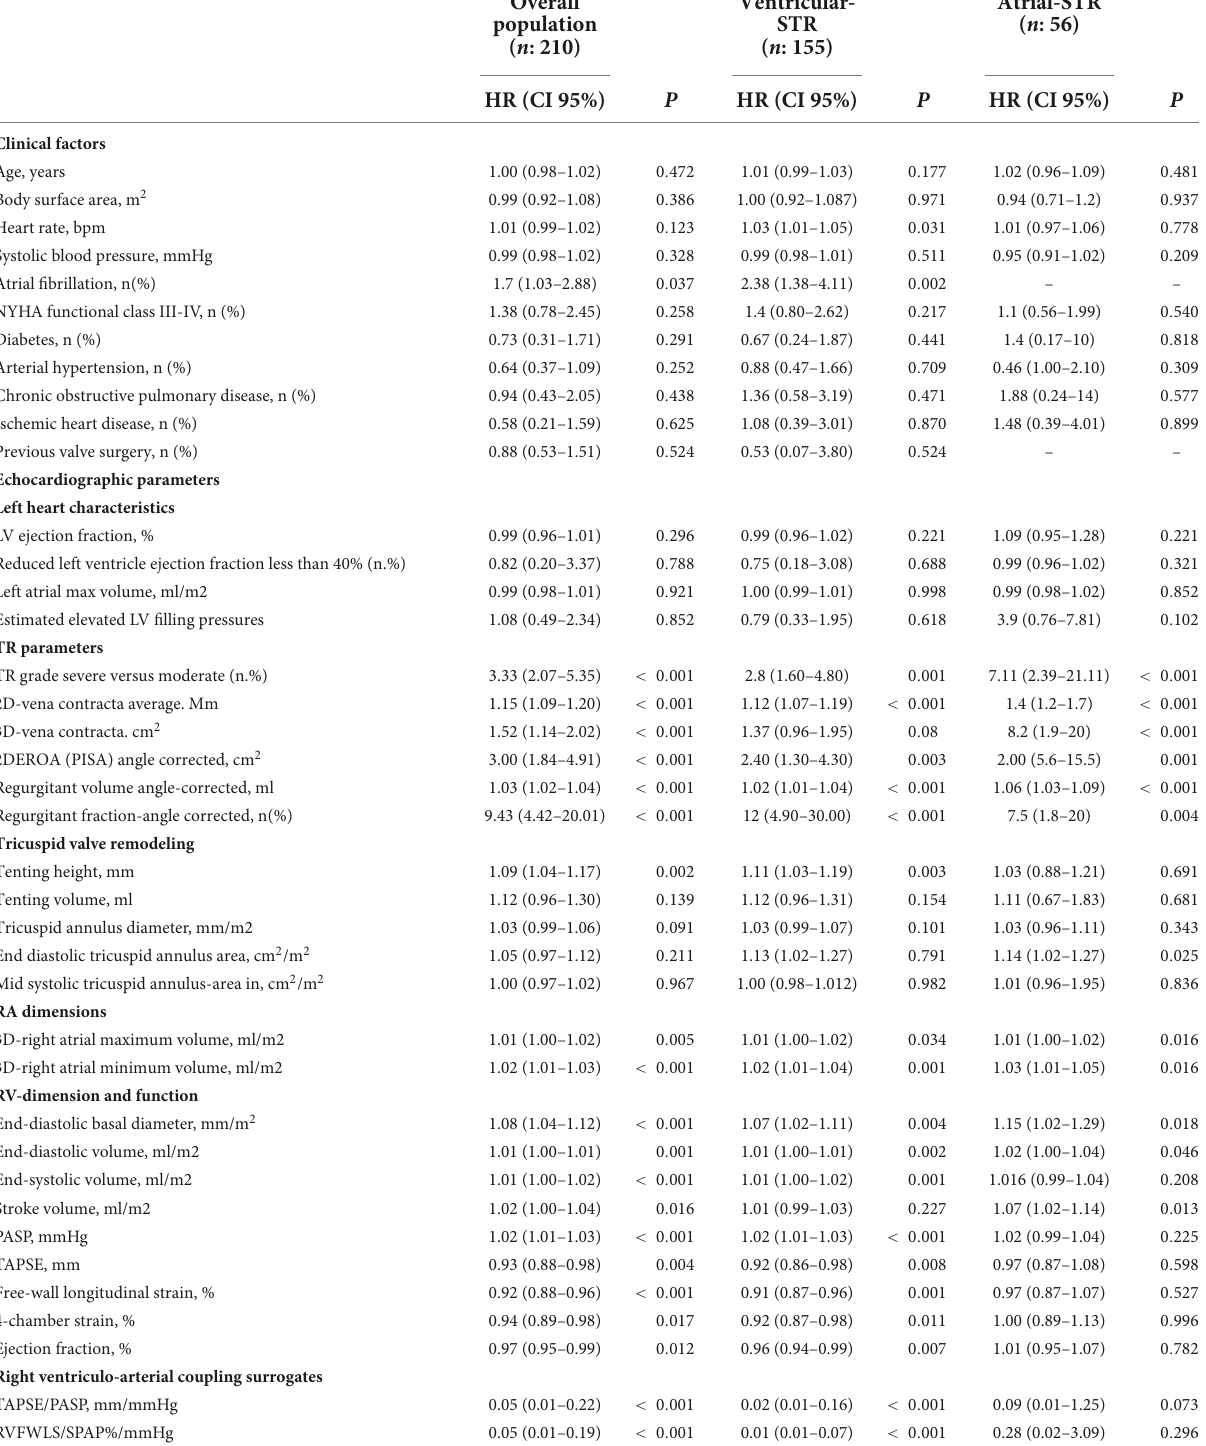
TABLE 3 Univariate Cox regression analysis of factors related to the combined endpoint in the whole cohort and in the 2 distinct phenotypes of STR.